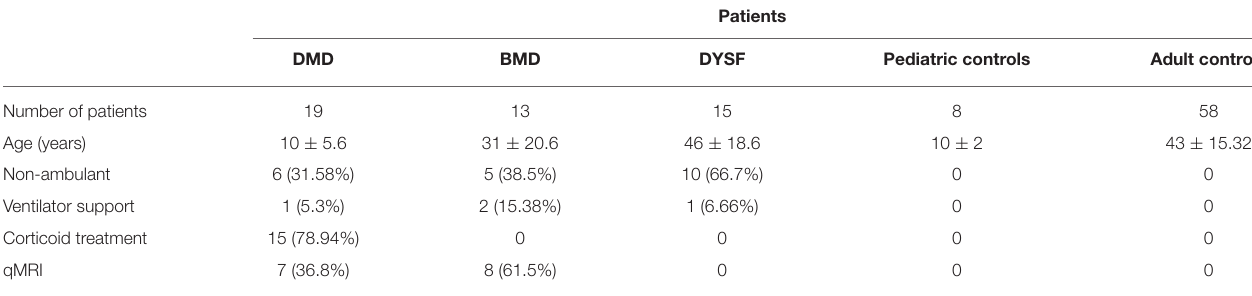
TABLE 1 | Clinical features of the subjects included in the study.